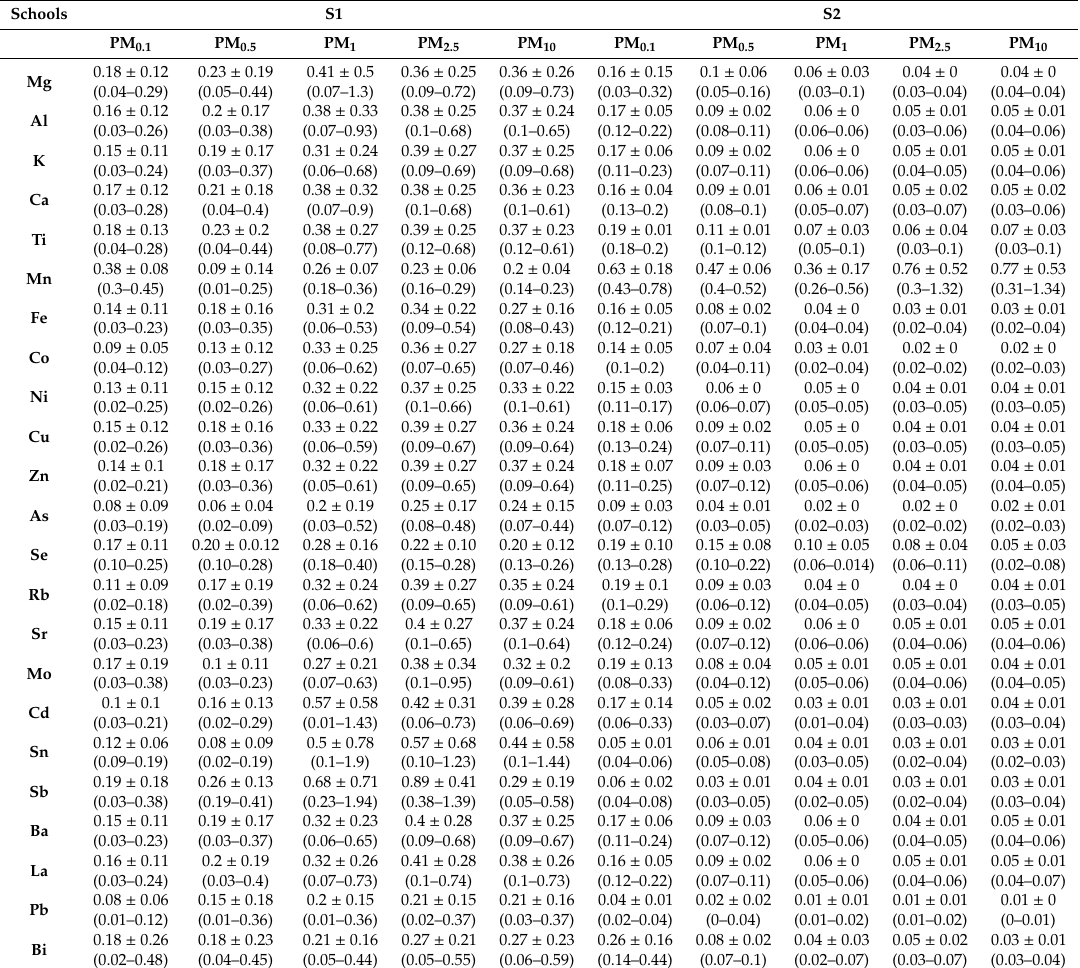
Table 5. Indoor to outdoor ratios (I / O ratios) of di ff erent elements sampled during the class at S1 and S2 (n = 80, average ± SD, in parentheses are min–max